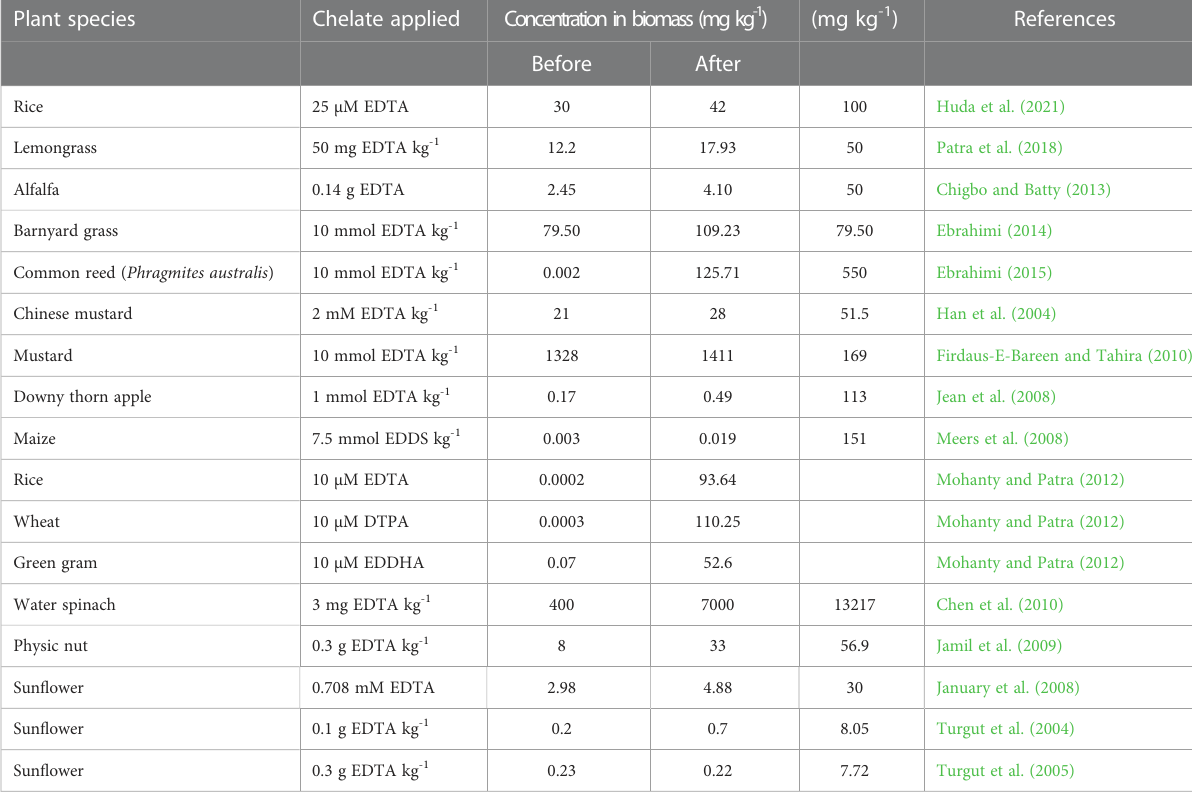
TABLE 5 Effect of chelates application for remediation of chromium in soil.